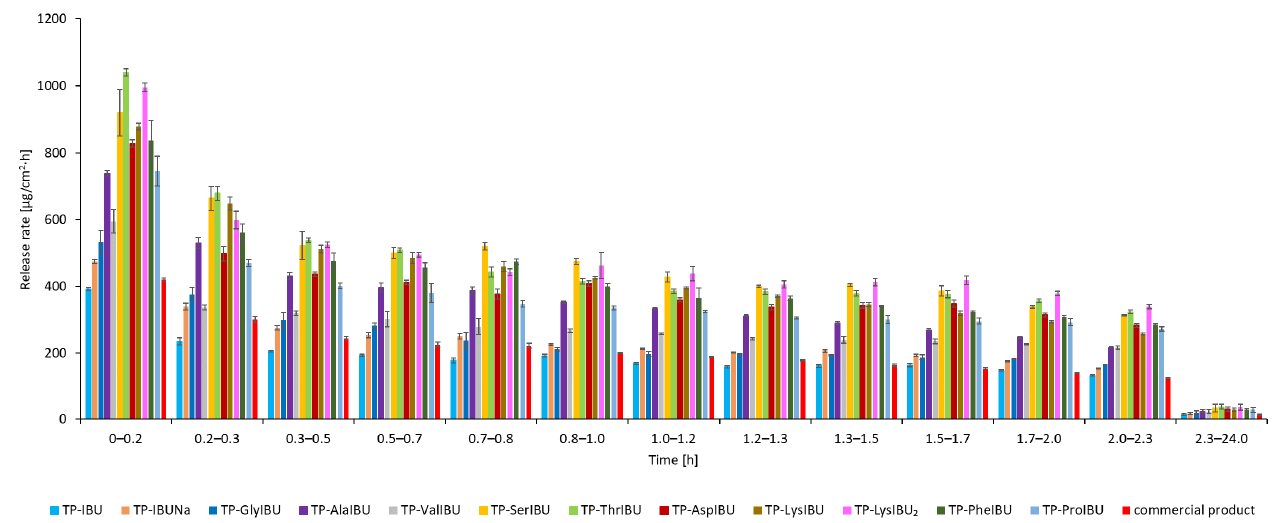
Figure 10. The release rate of ibuprofen and amino acid isopropyl ester ibuprofenates during the 24 h release; α = 0.05 (mean ± SD, n = 3).